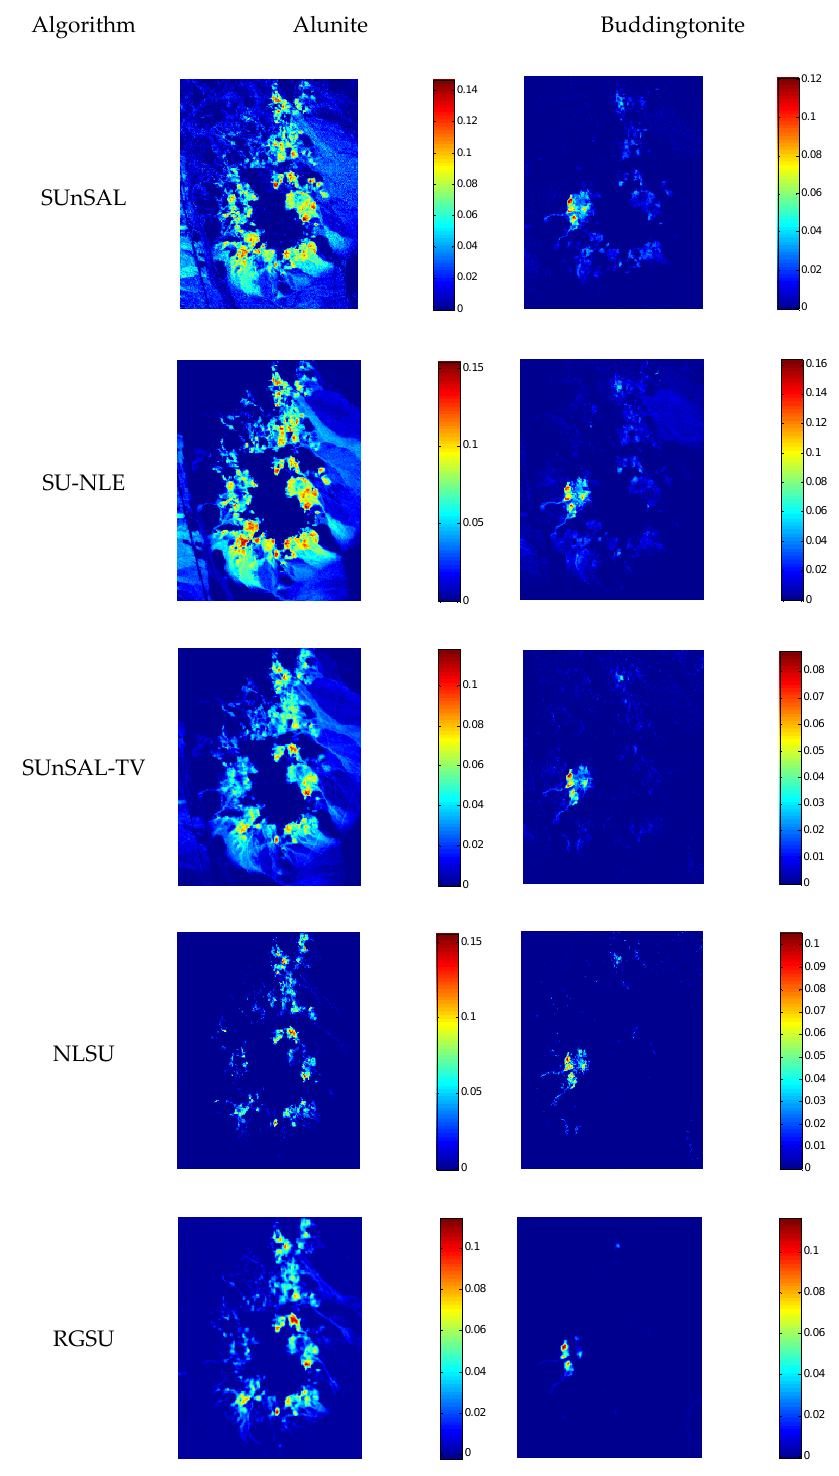
Figure 9. Estimated abundances of alunite and buddingtonite for the Cuprite dataset.